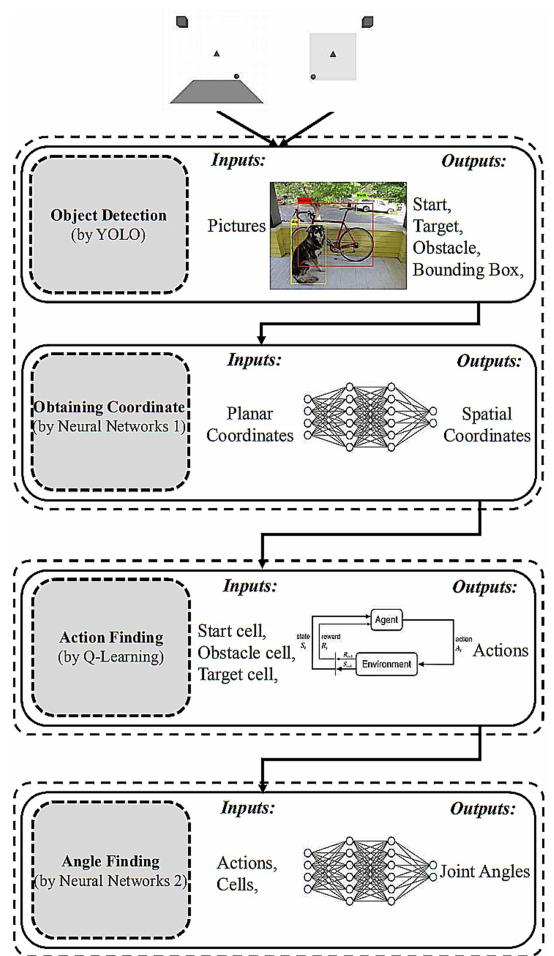
Figure 6. Method overview: 1. capturing pictures; 2. object detection by YOLO; 3. obtaining spatial coordinate by the first neural network; 4. action-finding by Q-learning; 5. angle-finding by the second neural network.